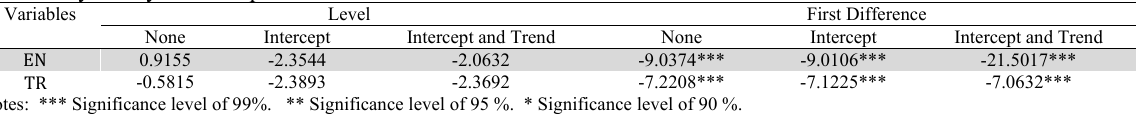
Stationarity test by the Phillip-Perron test.